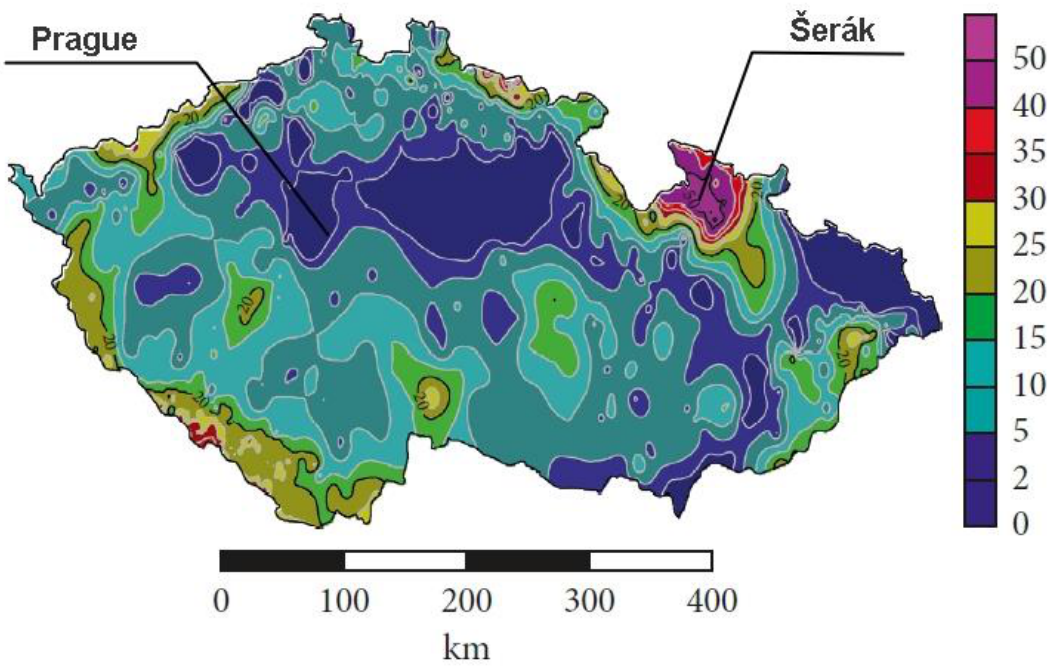
Figure 2. Freeze / thaw cycles map of the Czech Figure 2. Freeze/thaw cycles map of the Czech Republic.